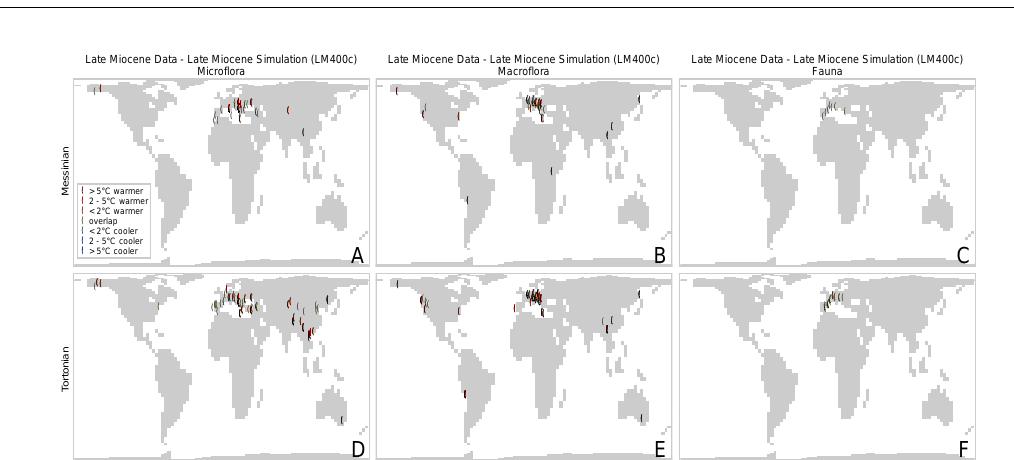
Fig. 9. Results from the model–data comparison for mean annual temperature, late Miocene